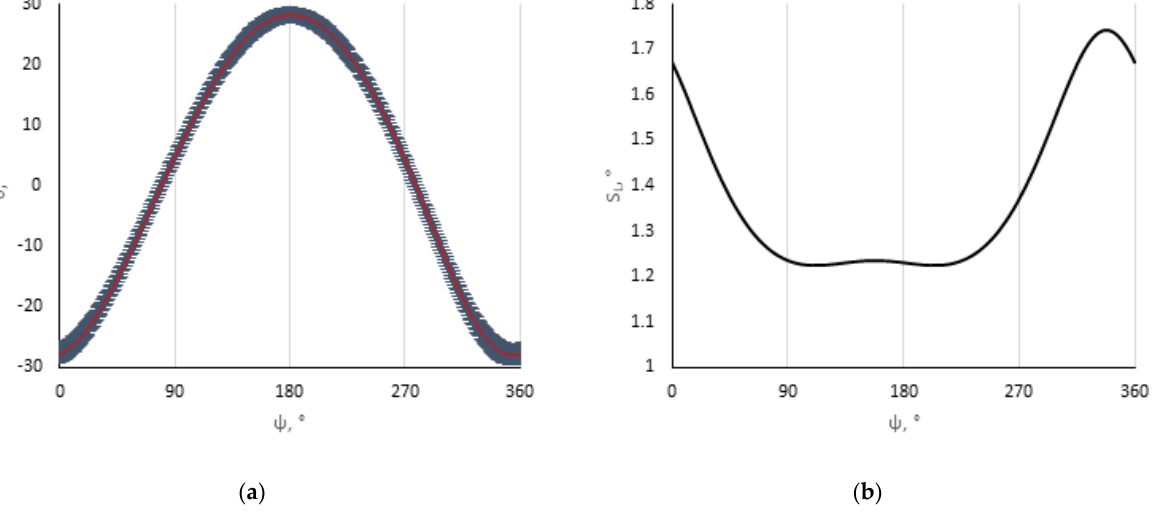
Figure 7. Curve illustrating : ( a ) values of composite quantity θ , together with standard measuring uncertainty due to the measurement of L . ( b ) standard measuring uncertainty values for composite quantity θ due to the measurement of L .